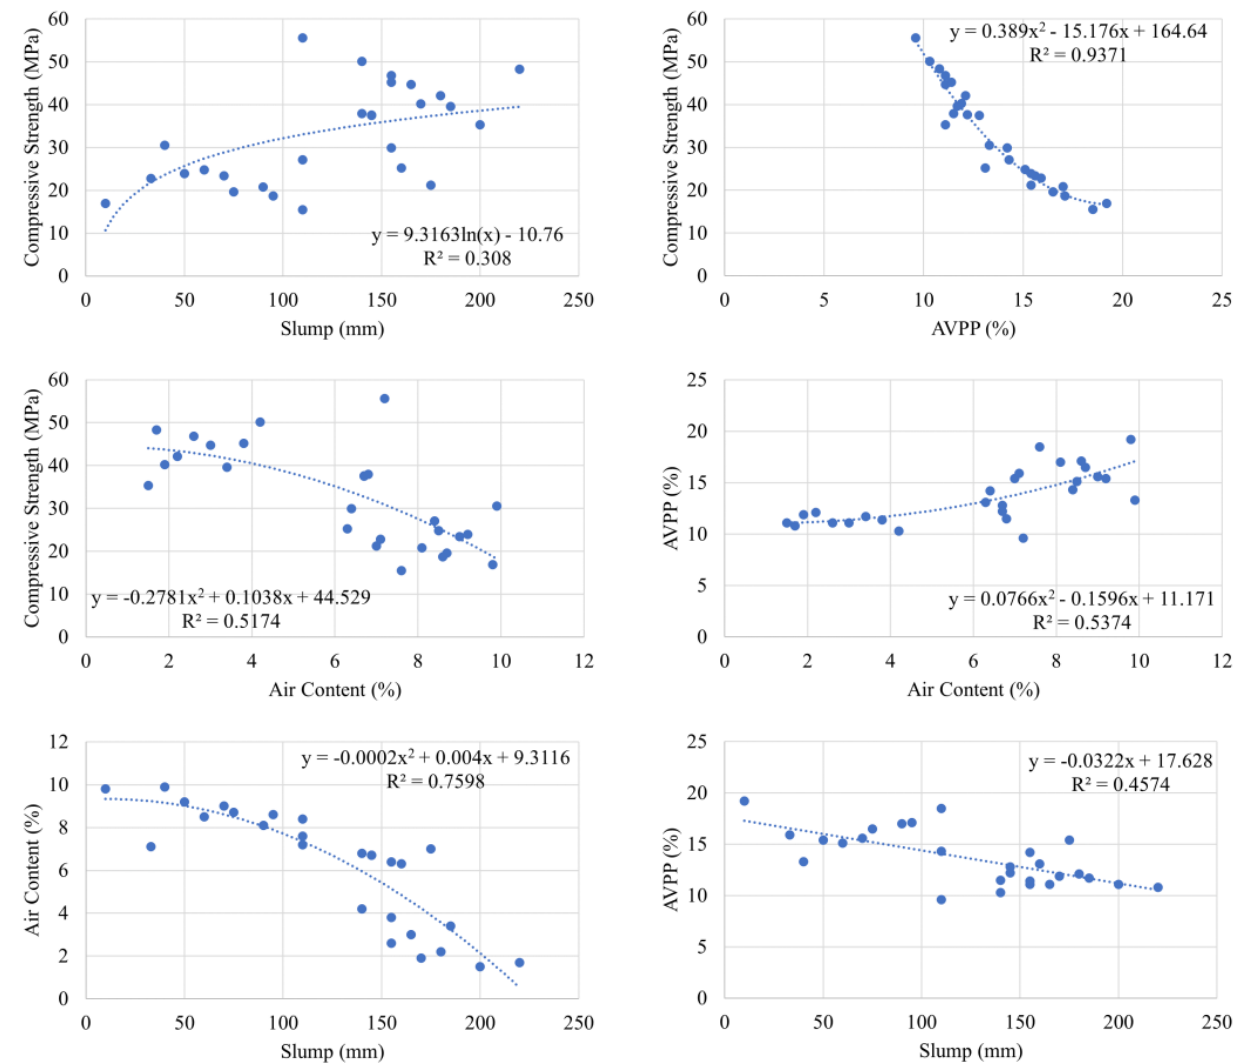
Figure 13. Relationships between the investigated